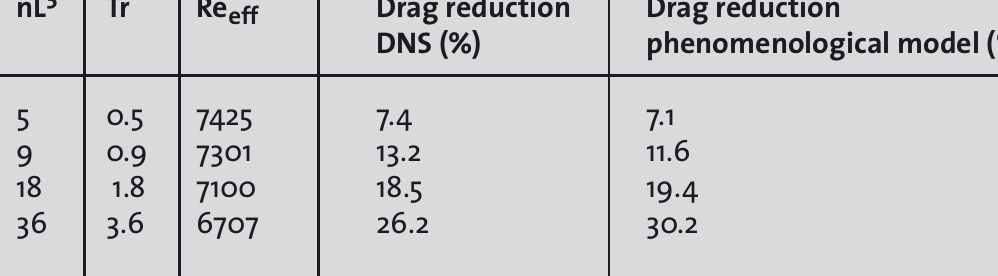
Table 1: A comparison of model with DNS for fiber drag reduction, U =